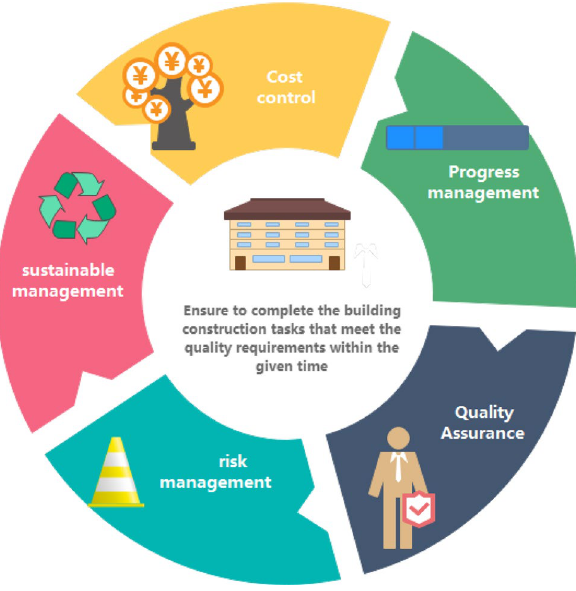
Figure 2. Engineering project management